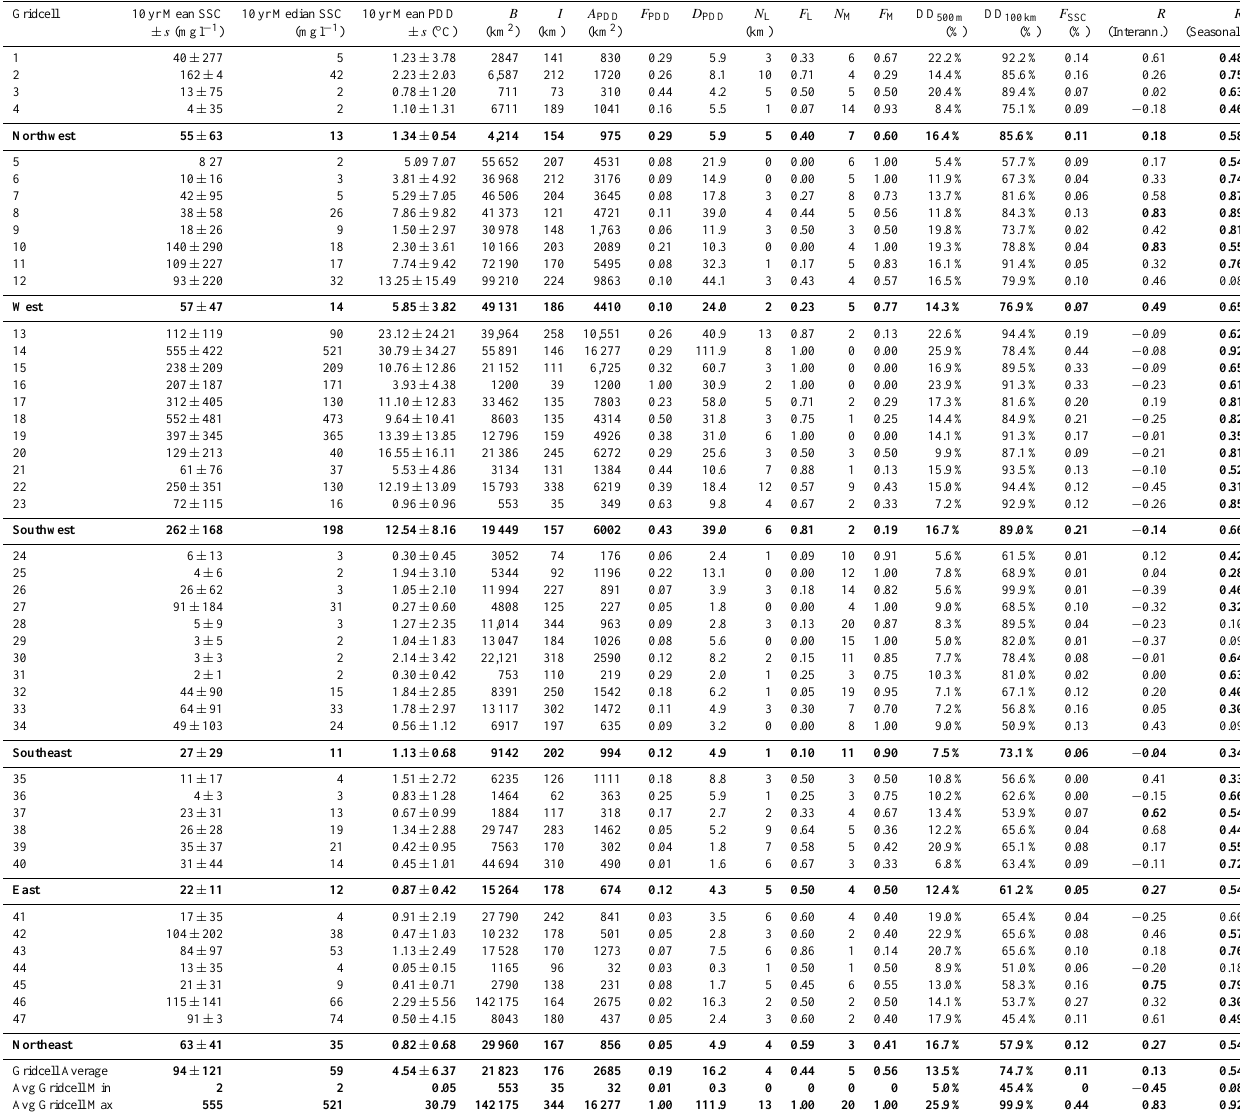
Table 1. All parameters for each of the 47 gridcells, which are grouped and averaged into six regions. 10yr mean SSC ± standard deviation ( s ), 10yr median SSC, and 10yr mean PDD ± s are shown with standard deviations, and region averages are shown with standard deviations of gridcell averages within the region. B is drainage basin size (with medians summarizing regions), I is horizontal ice edge length, A PDD is melt area within each drainage basin, F PDD is percent of drainage basin actively melting, D PDD is melt penetration distance, N M is number of marine-terminating glacier outlets, F M is the fraction of marine-terminating outlets, N L is number of land-terminating glacier outlets, F L is the fraction of land-terminating outlets, DD 500m is average data density of open water from raw 500m data, DD 100km is data density of open water from aggregated 100km gridcells, F SSC is sediment persistence (fraction of high-SSC days from total open water days), R (interannual) is the correlation between interannual variations of SSC and PDD over 2000–2009, and R (seasonal) is the correlation between 10yr mean seasonal cycles, with significant correlations ( p < 0 . 05) in